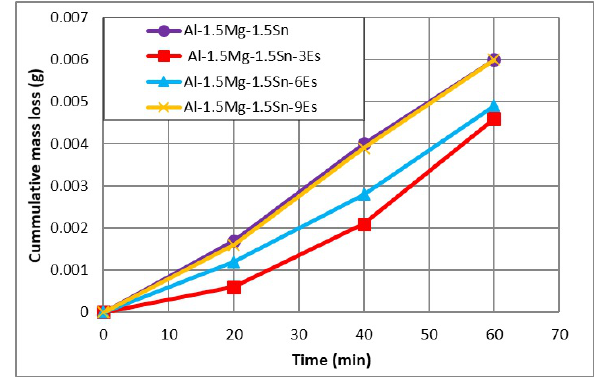
Figure 6: Variation of cumulative mass loss of Al-1.5Mg-1.5Sn-Es composites with varying eggshells percentage and sliding